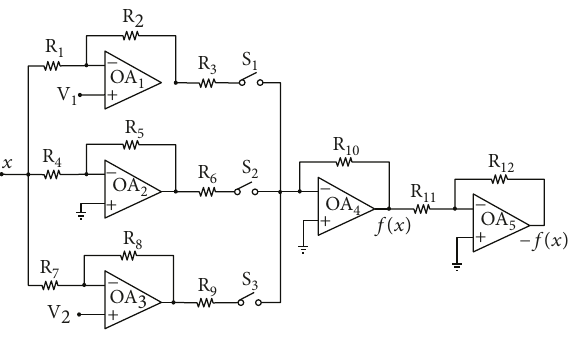
Figure 7: The programmable staircase function circuit.